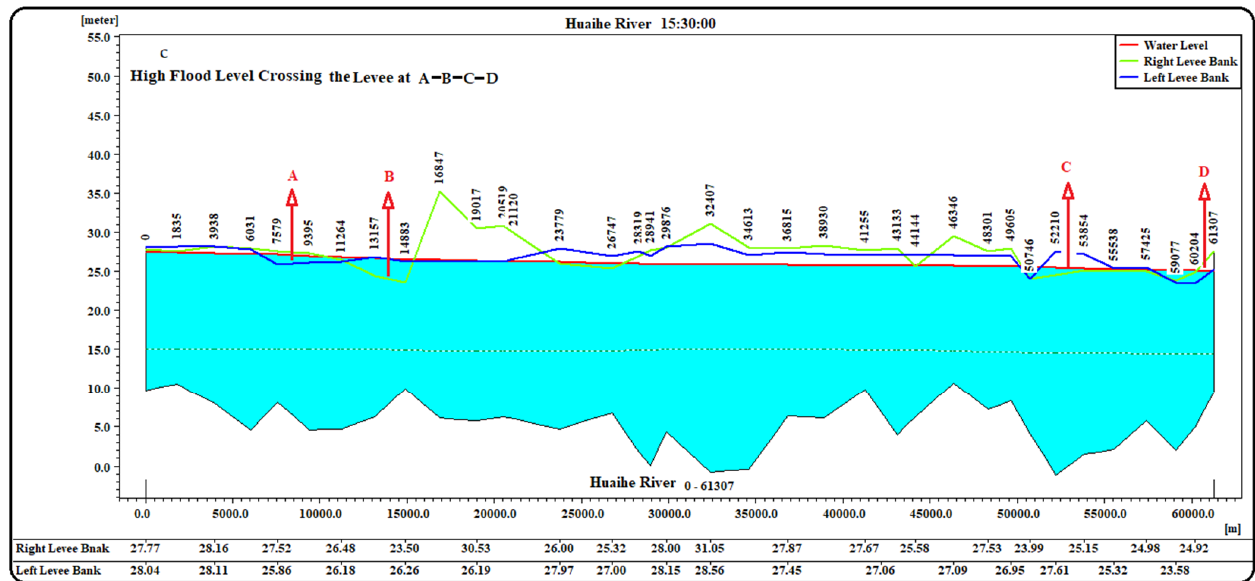
Figure 3. Profile view of simulated water level: indicating normal flow in figure ( a ), maximum flow line indicates high flood level in figure ( b ) and figure ( c ) shows dams breaking at A, B, C, and D points left and right levee.